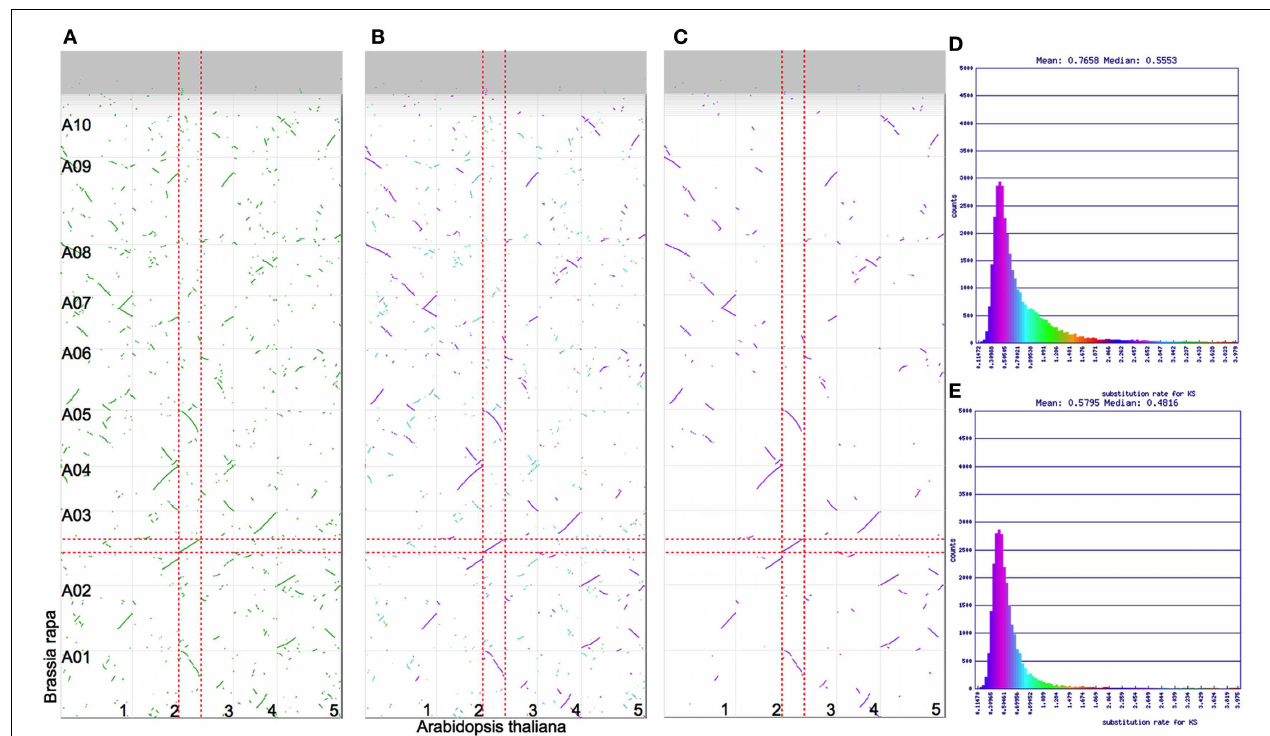
(C) Syntenic gene pairs after screening for a 3:1 ( rapa : thaliana ) syntenic depth.These are orthologous gene pairs. Results may be regenerated: http://genomevolution.org/r/4sl5. (D) Histogram of synonymous rate values for all syntenic gene-paris. Colors in this histogram are mapped to dotplot shown in (B) . (E) Histogram of synonymous rate values for syntenic gene pairs screened for a 3:1 syntenic depth. Colors are mapped to dotplot shown in (C)